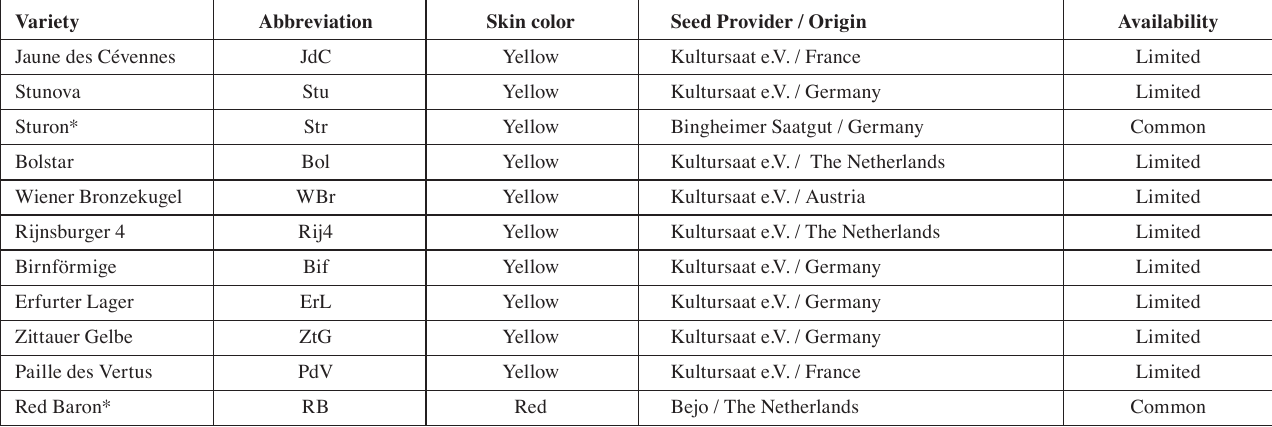
Tab. 1: Variety, skin color, country of origin or seed provider and market availability of analyzed open-pollinated onions.